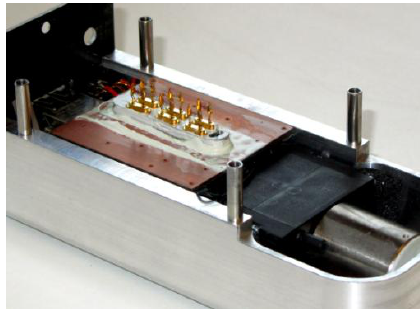
Figure 22. QCM sensor system without measuring chamber. A copper heat pipe and heat sink paste lead the heat from the oscillator off to the